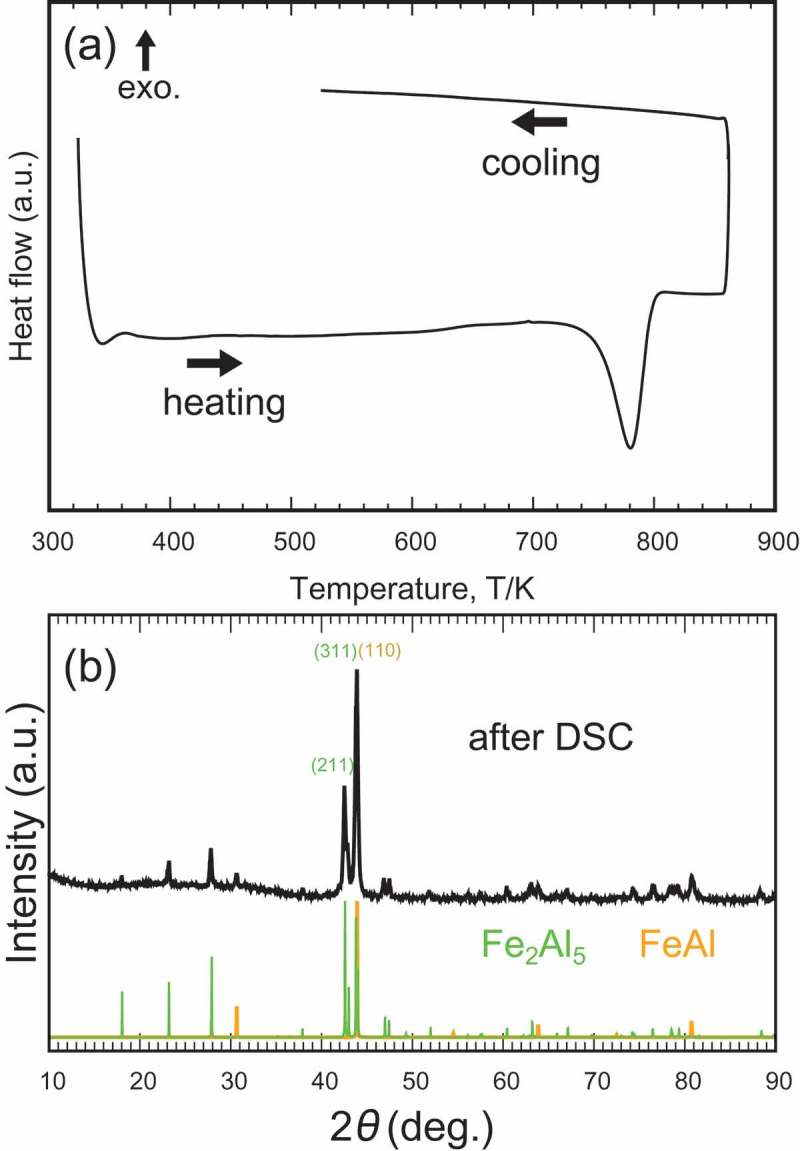
(a) DSC measurement with the endothermic signal at 787 K, which indicates decomposition of t-FeAl2. (b) X-ray diffraction patterns of t-FeAl2 after DSC measurement, which results in the complete decomposition into FeAl and Fe2Al5.